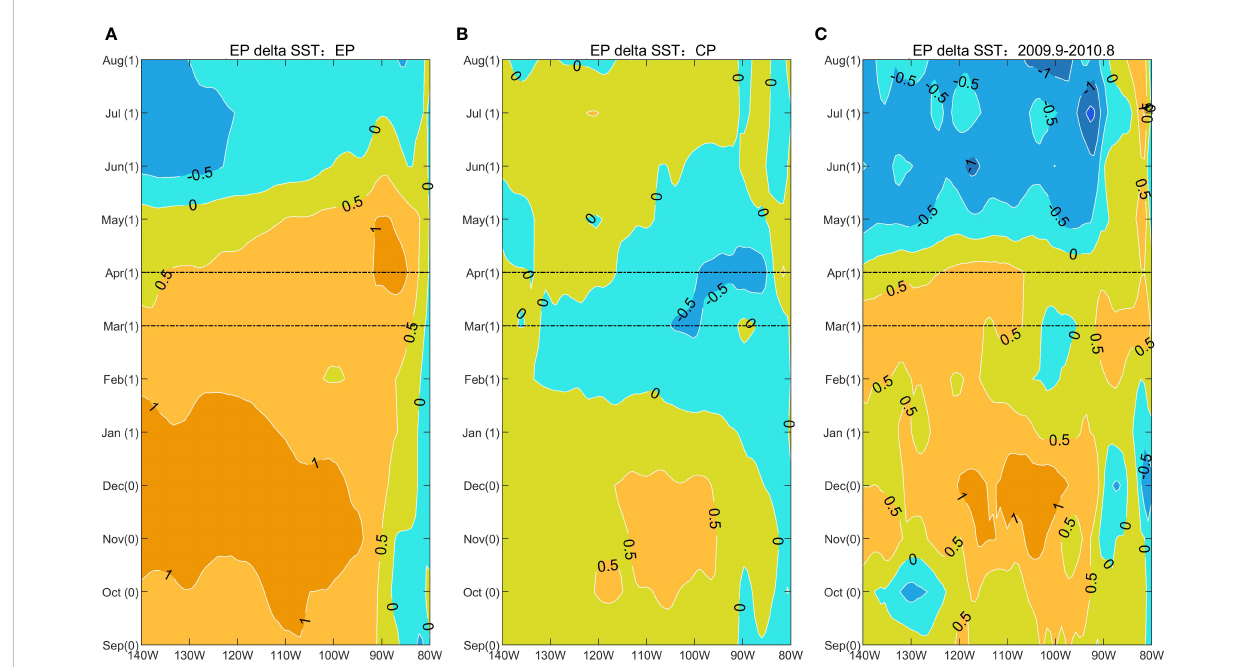
FIGURE 8 Time evolution of the EP-type delta SST over the eastern Paci fi c Ocean (140°W – 80°W) during three types of El Niño years: (A) the composite of EP- type El Niños; (B) the composite of CP-type El Niños and (C) the 2009/2010 mixed-type El Niño. The numbers in parentheses following the months are 0 for the developing year and 1 for the decaying year of El